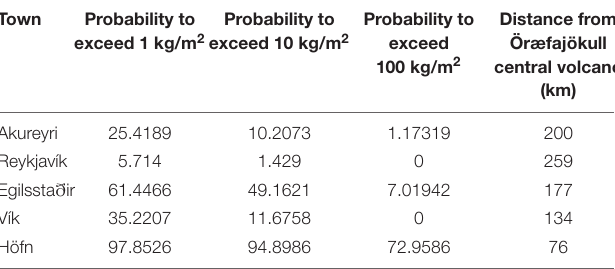
TABLE 4 | Likelihood of receiving specific amounts of tephra is calculated for five main towns in the country.